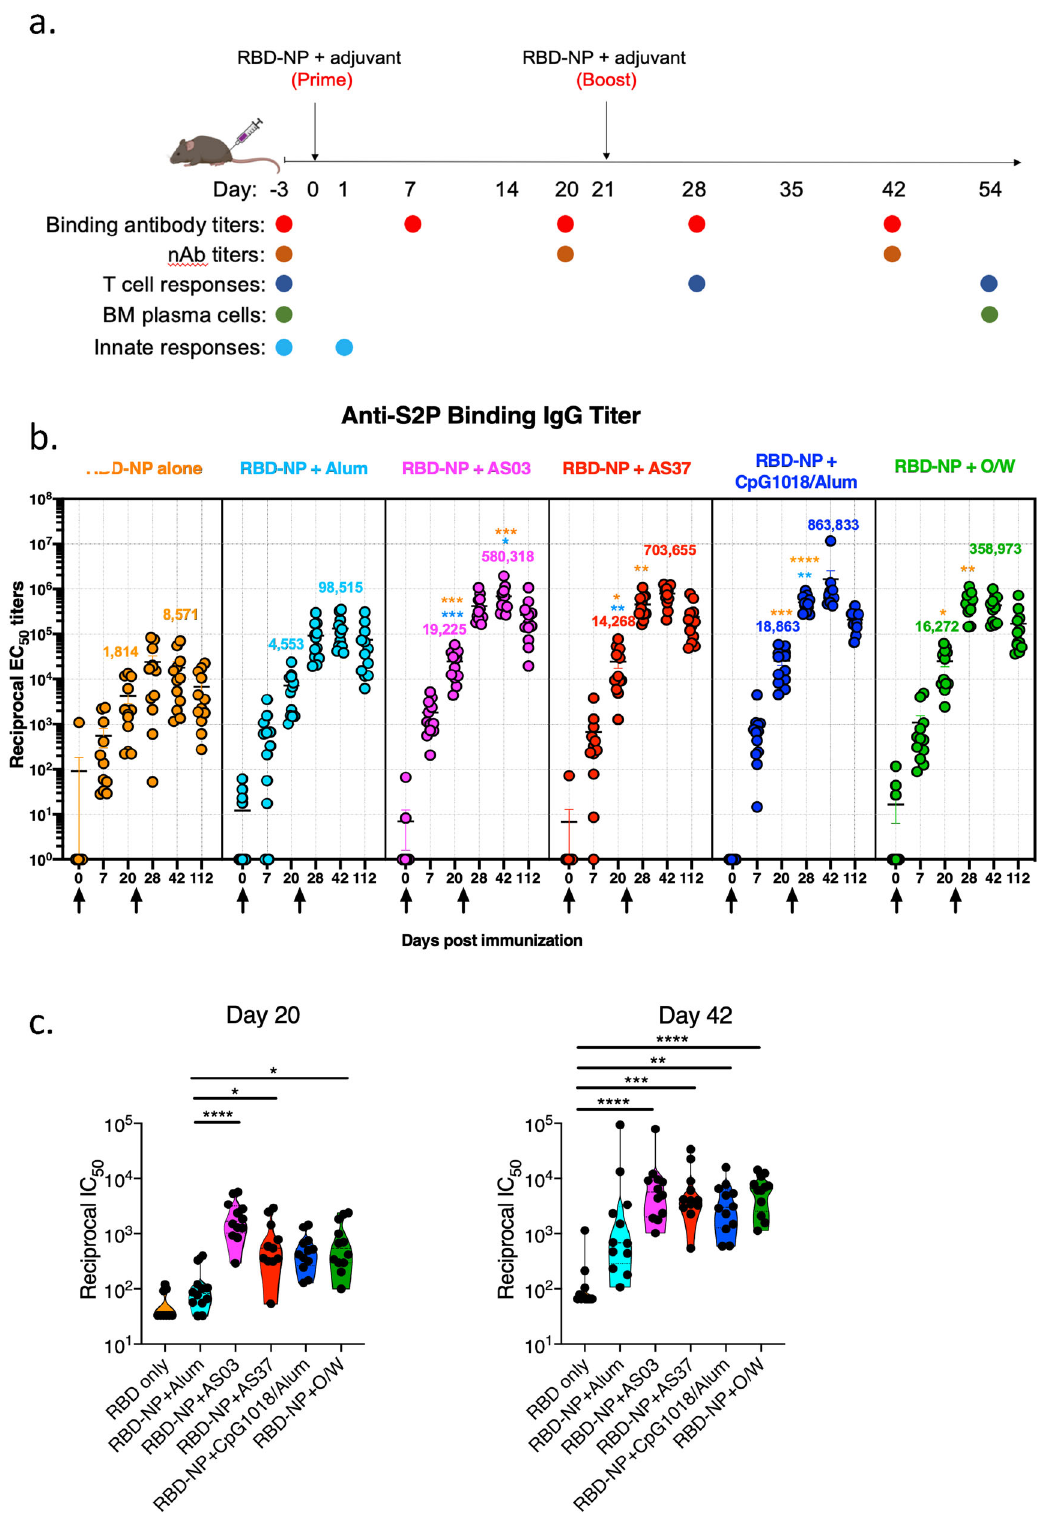
Fig. 1 Binding and neutralizing-antibody responses to immunization with RBD-NP and adjuvants. a Study design for measuring binding and neutralizing antibodies, T cell responses, BM plasma cells, and innate responses in C57BL/6 mice. b Spike-protein binding antibody titers in serum of mice immunized with RBD-NP in various adjuvants at days 0, 7, 20, 28, and 42 post-immunization. Error bars indicate mean ± SEM. c Neutralizing-antibody titers measured by pseudovirus neutralization assays at days 20 (prime-only) and 42 (prime-boost). P -values: * denotes p < 0.0332, ** p < 0.0021, *** p < 0.0002, and **** p <